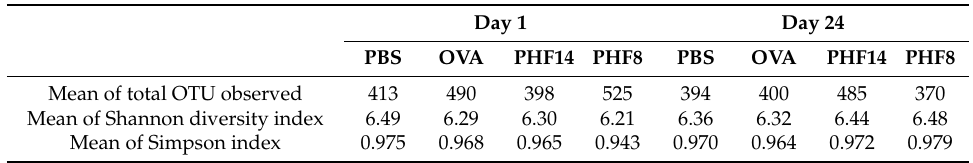
Figure 3. The quality of 16S rRNA gene (V3-4 regions), observed species number in the stool samples, distinct Operational Taxonomic Unit (OTU) observed and disparity in the abundance of each microbial species. Stool samples were collected on day 1 before sensitization and on day 24 before sacrifice. ( A ) Representative cropped gel electrophoresis of the PCR products of 16S rRNA gene (466 base pairs) of stools collected on day 1, as amplified by the 16S rRNA primers. M: DNA ladder DL1000. NTC: negative control. Full-length gel is presented in Supplementary Figure S2. The digital image was captured with a single exposure at 500 ms under UV06 filter and TLUM Mid-Wave light. ( B ) Rarefaction curves of 16S rRNA in stool samples of each mice (#1–4) upon H 2 O, 14-day PHF treatment or 8-day PHF treatment on day 1 and day 24. Observed specie number in each mouse was shown by line chat. ( C ) Venn diagram of shared OTU observed in the stool samples of mice on day 24 ( n = 4). ( D ) Rank-abundance curve of microbial species in each stool sample ( n = 4). PBS: healthy control; OVA: OVA-induced allergic asthmatic control; PHF14: mice with 14-day PHF treatment; PHF8: mice with 8-day PHF treatment; D1 and D24: day 1 and day 24, respectively. Table 2. OTU richness, diversity and evenness of total microbiota identified in stool samples of allergic asthmatic mice on day 1 and day